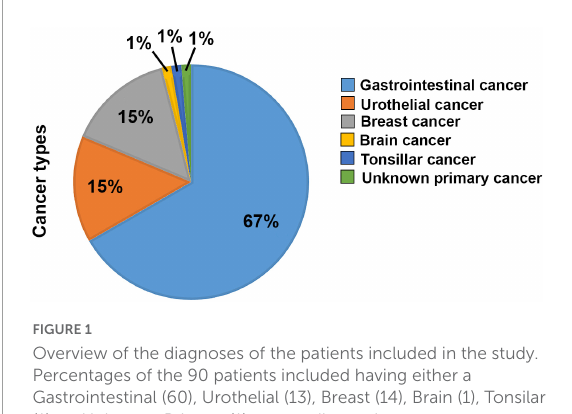
FIGURE1 Overview of the diagnoses of the patients included in the study. Percentages of the 90 patients included having either a Gastrointestinal (60), Urothelial (13), Breast (14), Brain (1), Tonsilar (1), or Unknown Primary (1) cancer diagnosis.